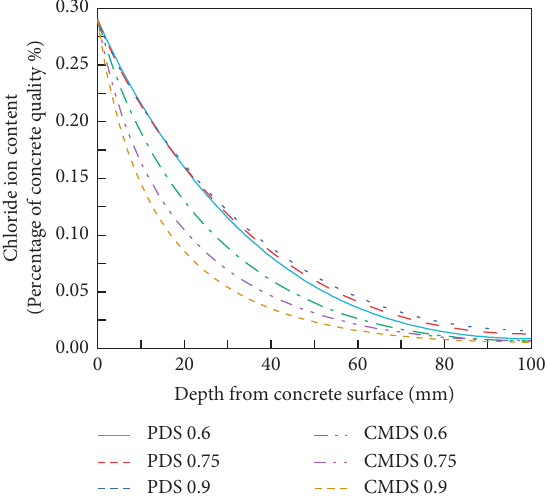
Figure 12: Chloride content distribution under diffusion and coupling action for moisture desorption.